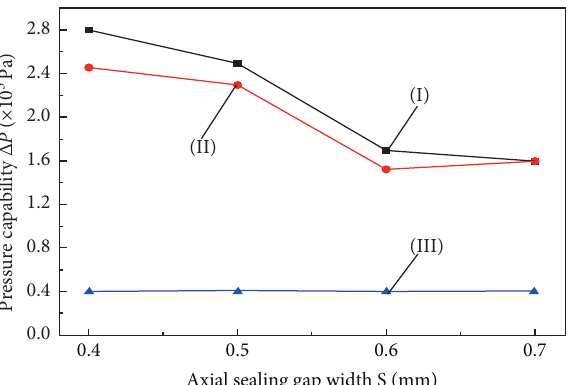
Figure 15: Influence of axial clearance on pressure resistance ability of magnetic fluid seal. (I) Experimental value of divergent magnetic fluid seal. (II) Theoretical value of divergent magnetic fluid seal. (III) Experimental value of ordinary magnetic fluid